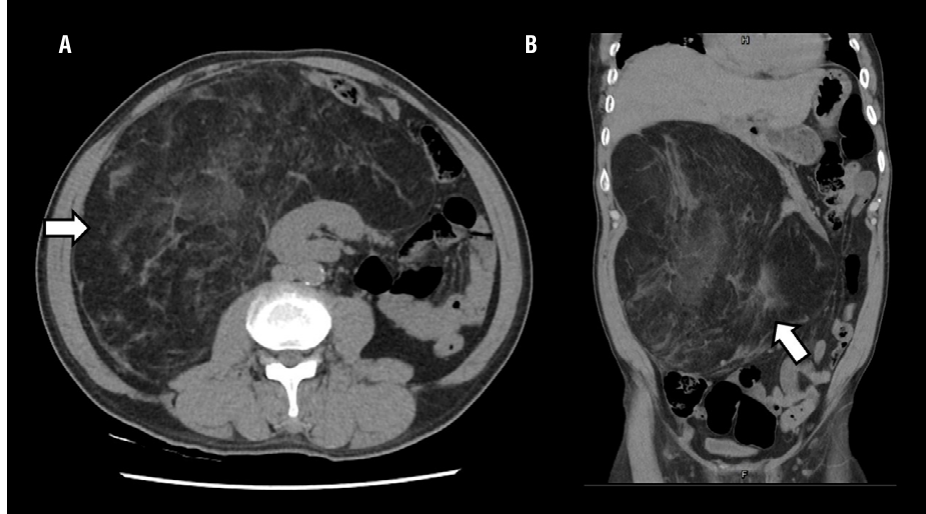
Figure 1 - A) Right kidney dislocated in epigastrium by the retroperitoneal component of the mass. B) Right colon displaced against abdominal wall and most of the small bowel in left side of